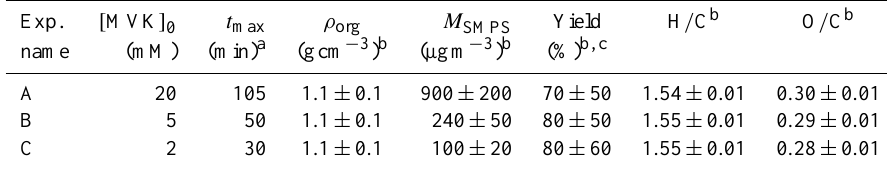
Table 3. Overview of aerosol properties and mass yields for different initial MVK concentrations. Exp. [ MVK ]